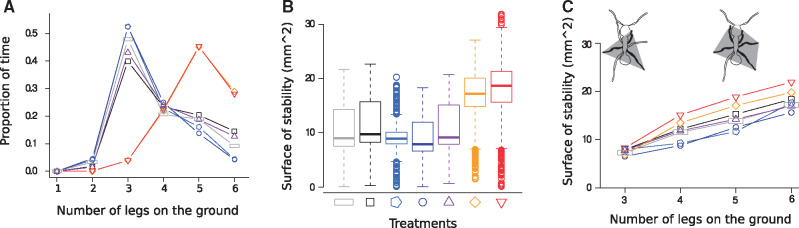
Ant stability for the different treatments. A) Proportion of time spent with different number of legs on the ground of the factorial design experiments. Each line is the mean value of all ants recordings per treatment. B) Surface of stability polygon in mm2. Each boxplot includes the front, middle, and hind legs for all ants of the corresponding treatment. C) Mean surface of stability as function of the number of legs on the ground. The surface of stability is sketched in gray for the cases of three and five legs on the ground. See Fig. 3 for the explanation of the symbols representing the different treatments.